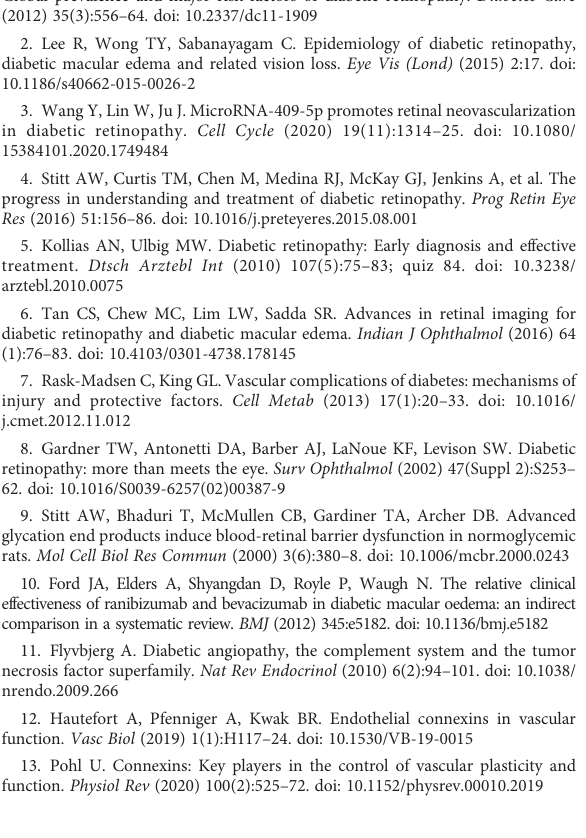
SUPPLEMENTARY FIGURE 1 Images with the fl uorescein signal combined with the fsc/ssc scatter. SUPPLEMENTARY FIGURE 2 Effects of 60 mmol/L HG and antioxidant (N-Acetyl Cysteine,